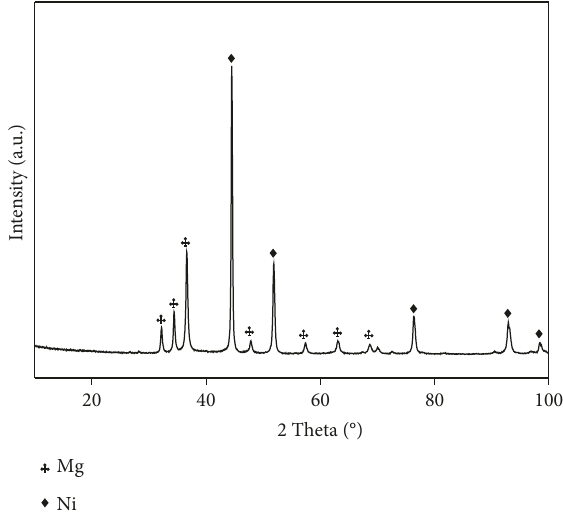
Figure 2: XRD pattern of HCX-1 ball milling at 900–1100rpm for 13 h.